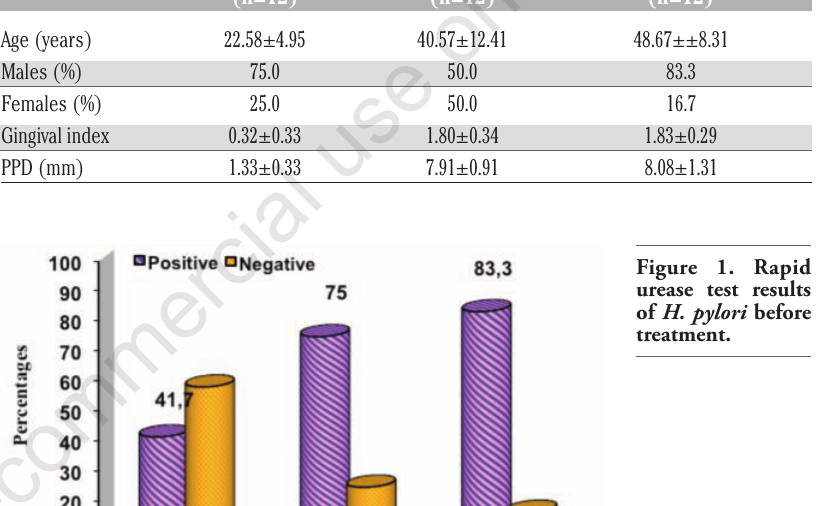
Figure 2. Preva - lence of H. pylori after the